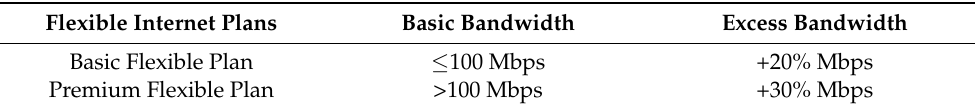
Table 1. Flexible Internet plans offered by Internet service providers (ISPs)/network